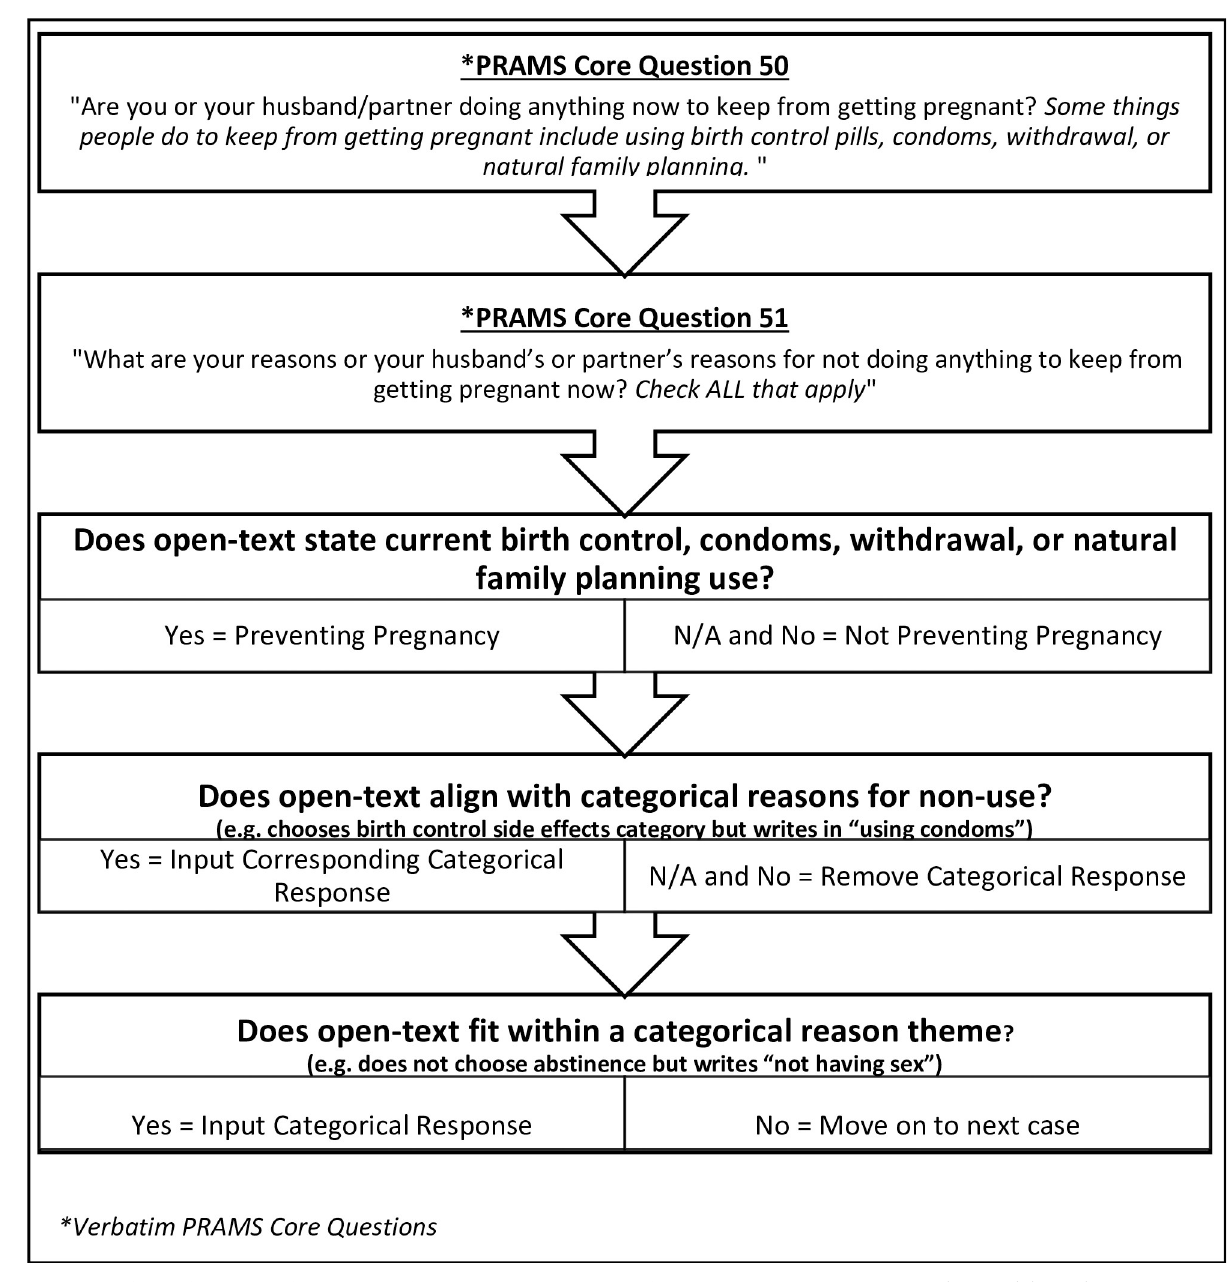
text responses for data familiarization, open-coded for preliminary trends, deliberated on a